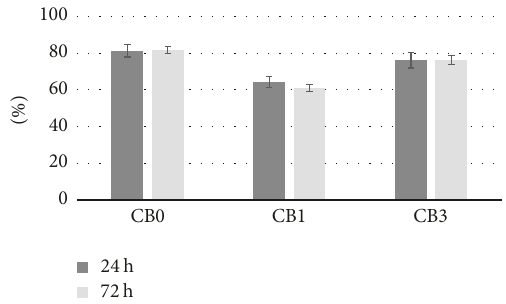
Figure 5: Swelling ratios of membranes after 24 and 72 hours obtained at simulated physiological conditions (37 ∘ C, pH 7.2).